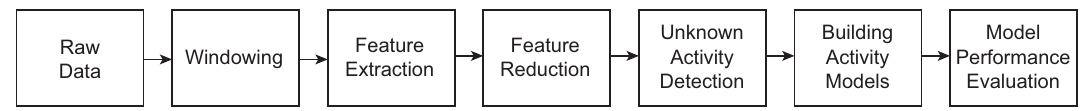
Figure 3. Methodology implemented in the case study for HAR